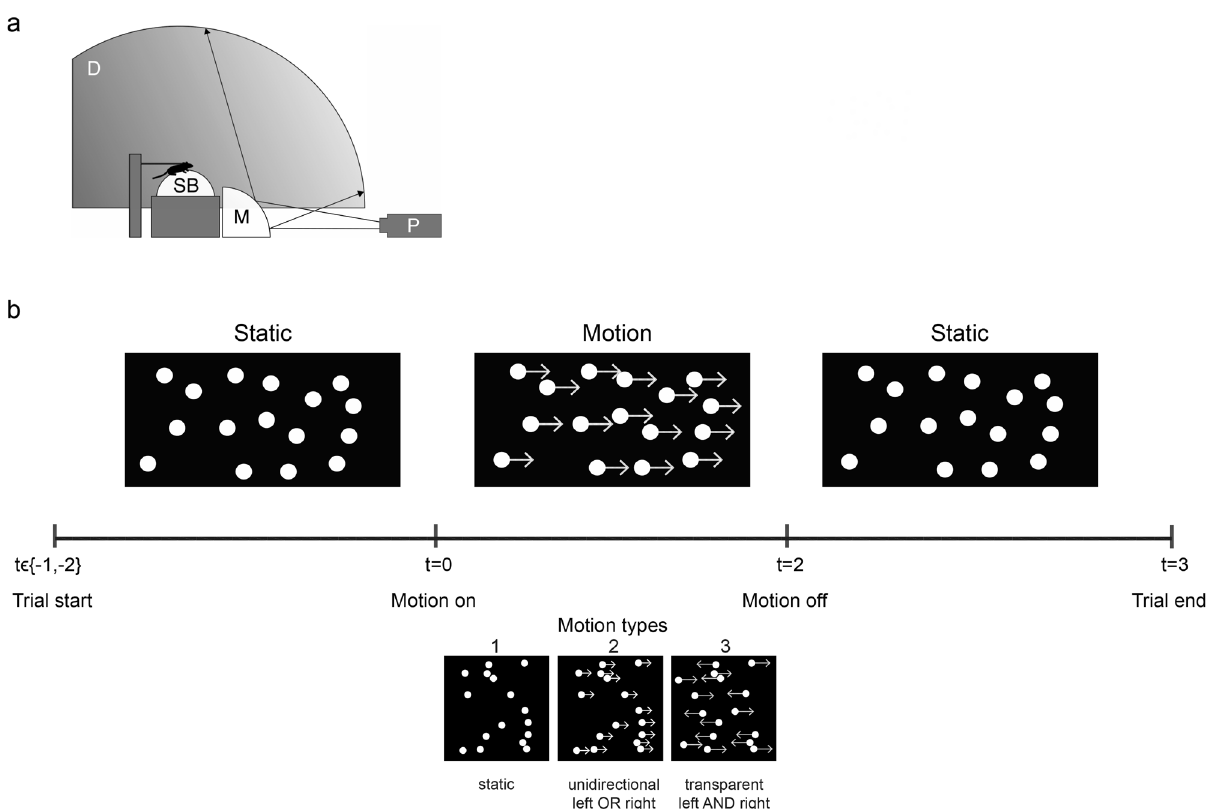
Figure 4. Experimental setup. ( a ) Schematic drawing of the setup. Projector (P) displayed patterns of randomly positioned dots via a mirror (M) onto the inside of a dome (D). Mice ran under head-fixed conditions on a Styrofoam ball (SB) floating on air. ( b ) The time course of trials for (moving) dot patterns. Trials started with presentation of either 1 or 2 s of stationary dots followed by 2 s of one of four “motion types” (1) static, (2) unidirectional leftward OR rightward moving at 36 deg/s or (3) bidirectional transparent leftward AND rightward moving at 36 deg/s. Trials ended with 1 s of stationary